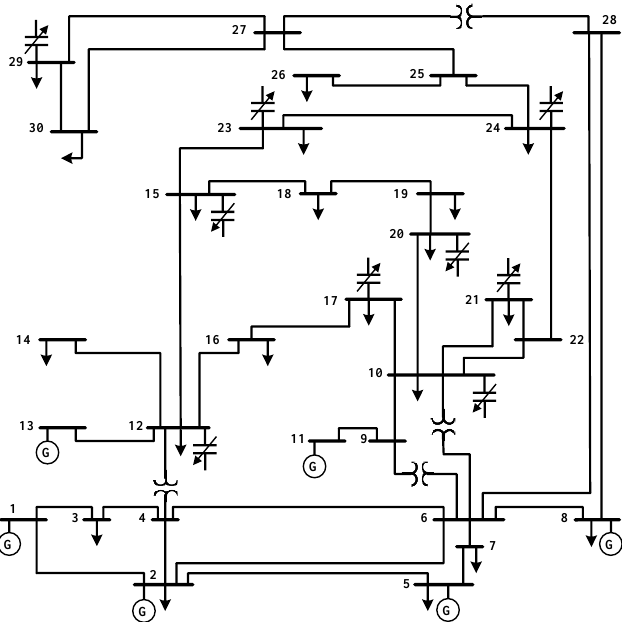
Figure 2. The single line diagram of IEEE 30-node system.